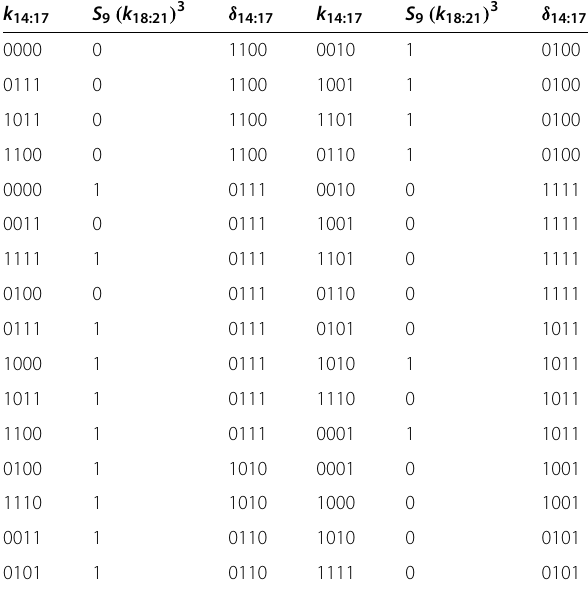
Table 3 Master key difference satisfy invariant bias condition